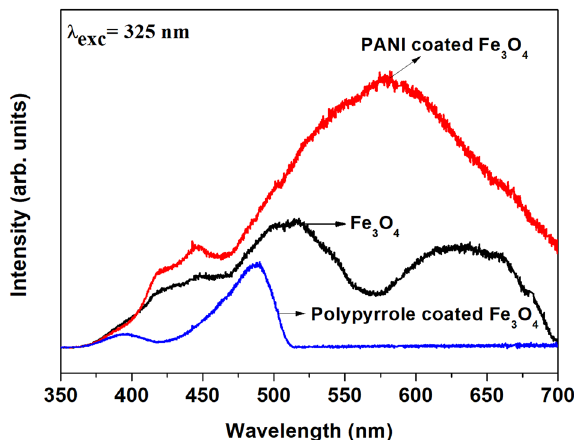
Fig. 6 Photoluminescence spectra of Fe 3 O 4 , PANI-coated Fe 3 O 4 and polypyrrole-coated Fe Fig. 8 Cytotoxicity studies of MTT assays for different concentrations